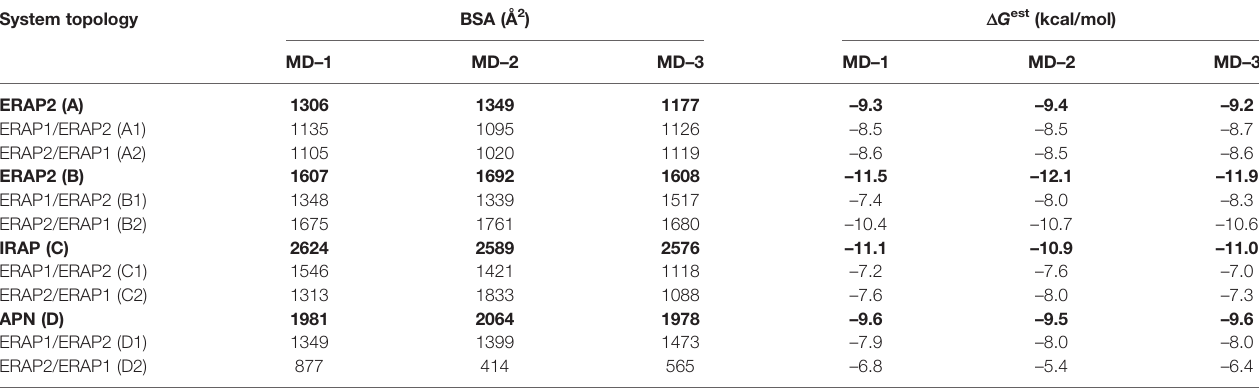
TABLE 2 | Summary of mean buried surface area (BSA) and mean estimated binding free energy ( D G est ), calculated from triplicate 100 – ns MD simulations of each system (designated as in Table 1 ). System